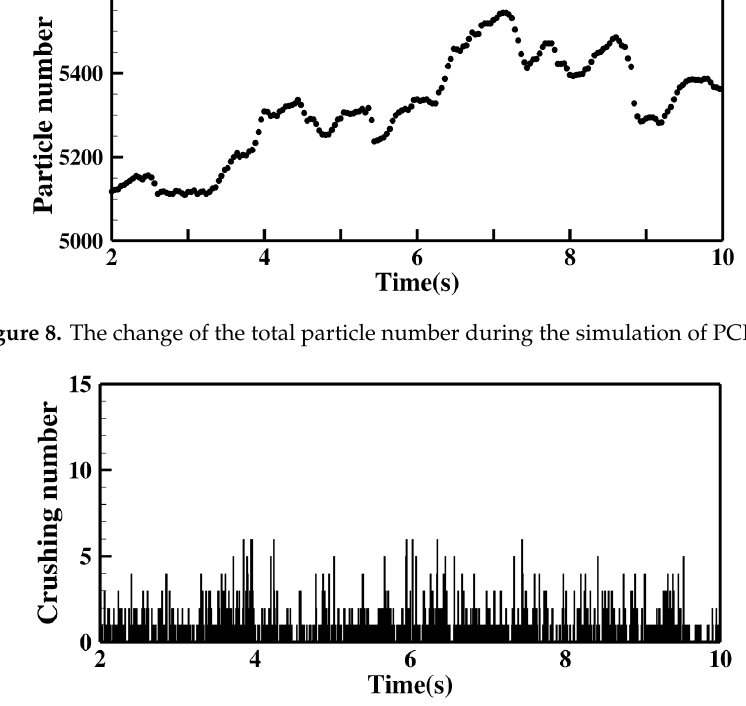
Figure 9. Particle-group crushing amount at different time instants during the simulation of PCPM.